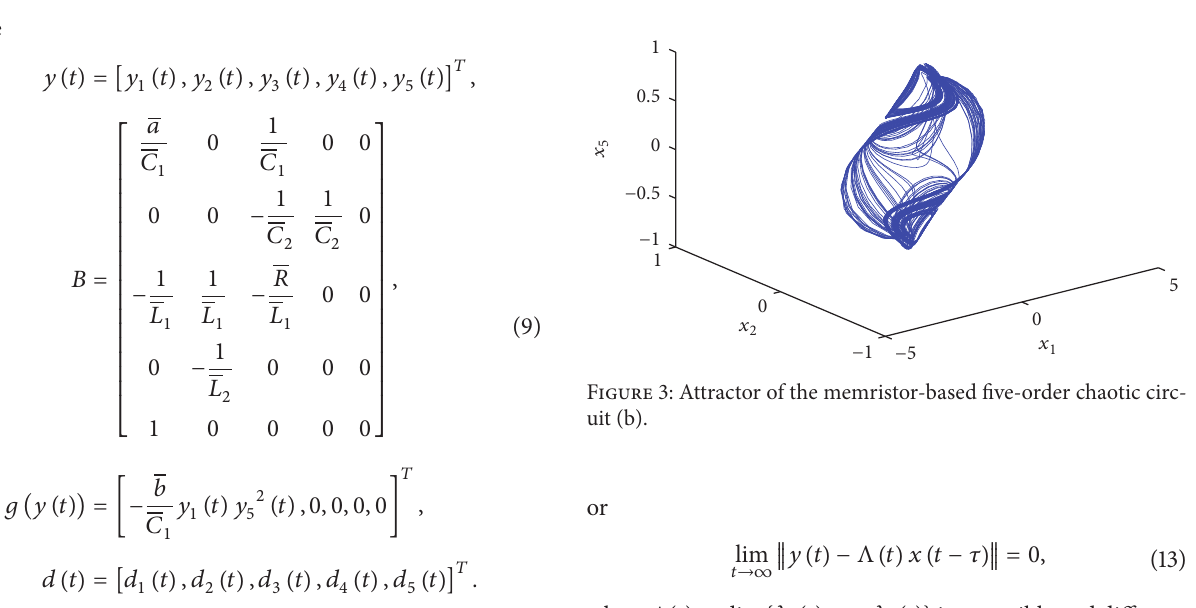
where Λ(𝑡) = diag {𝜆 1 (𝑡), . . . , 𝜆 5 (𝑡)} is reversible and differen- tiable and 𝜆 𝑖 (𝑡) ̸= 0 is a bounded continuously differentiable